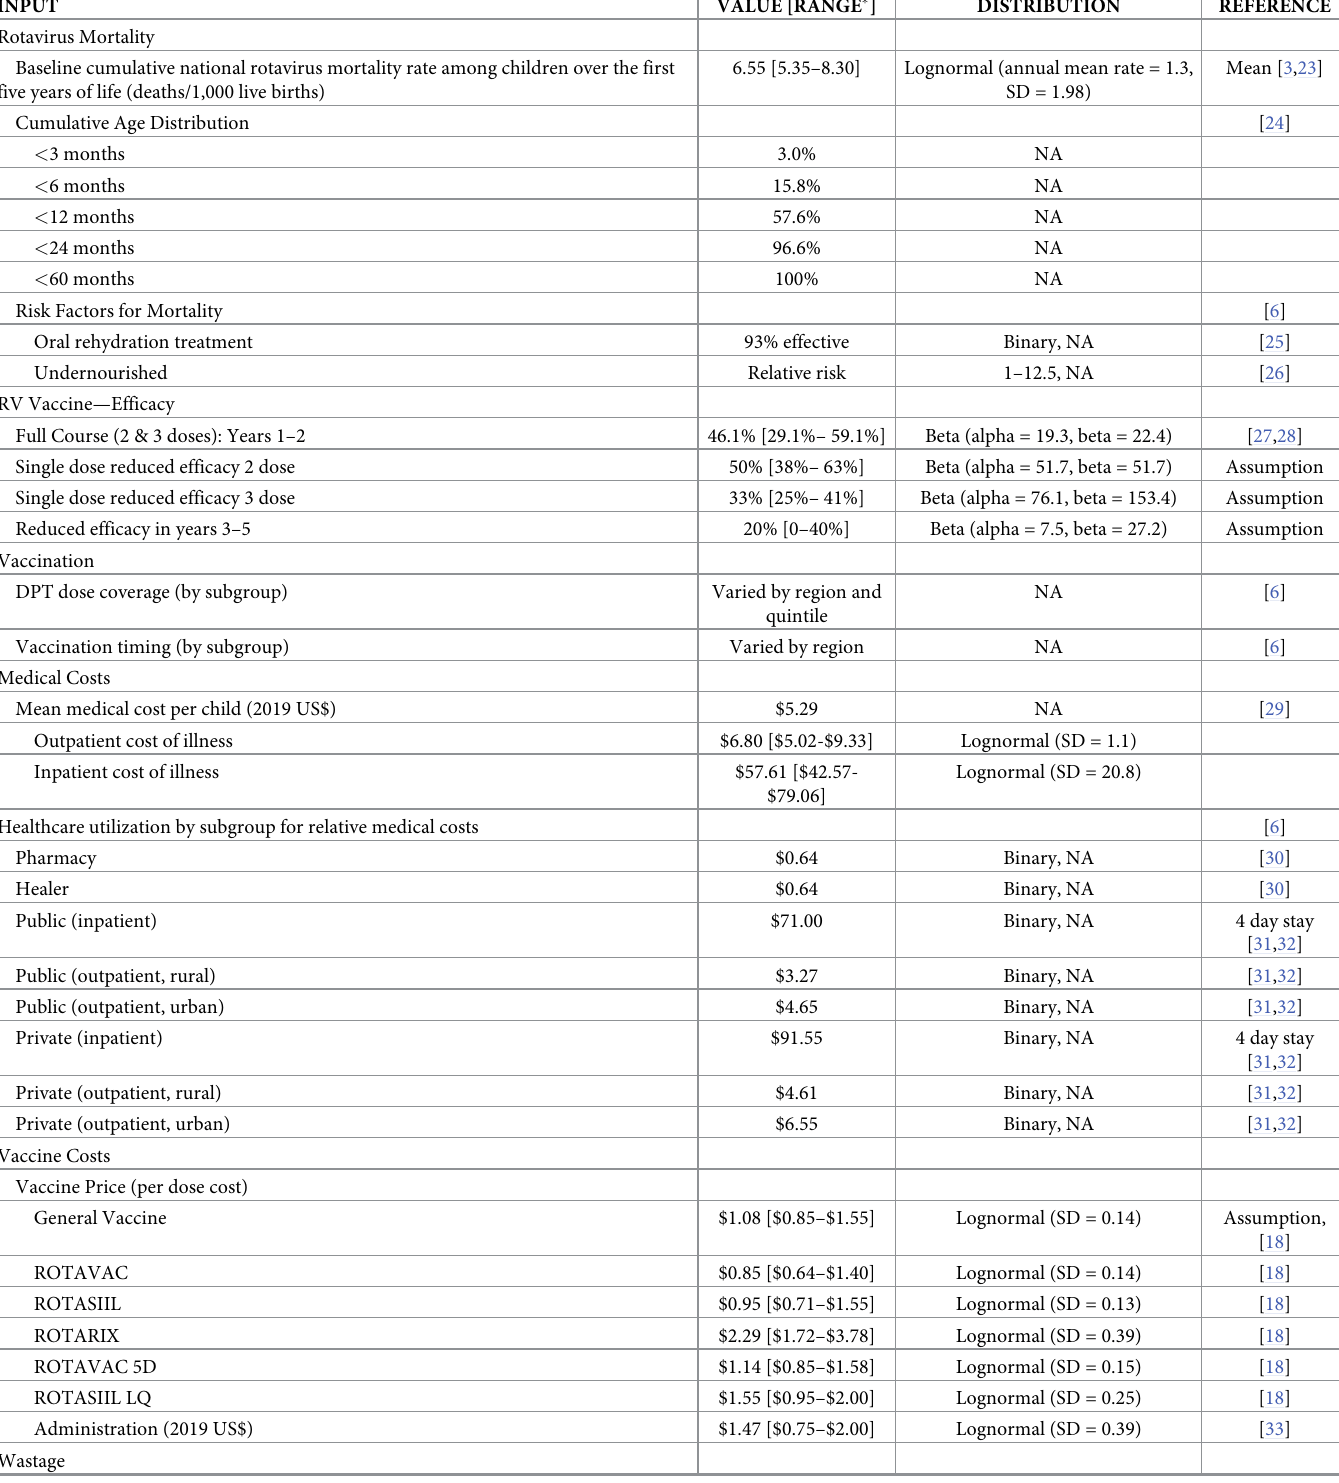
Table 1. Rotavirus cost-effectiveness model input parameter values, distribution range, and vaccines used in uncertainty and sensitivity analyses. All costs are pre- sented in 2019